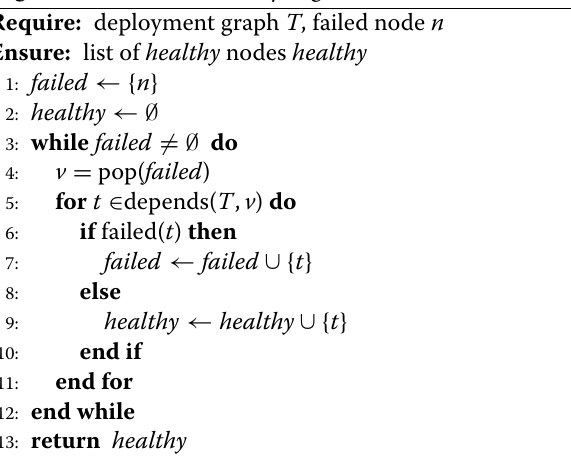
Algorithm 1 Error Recovery